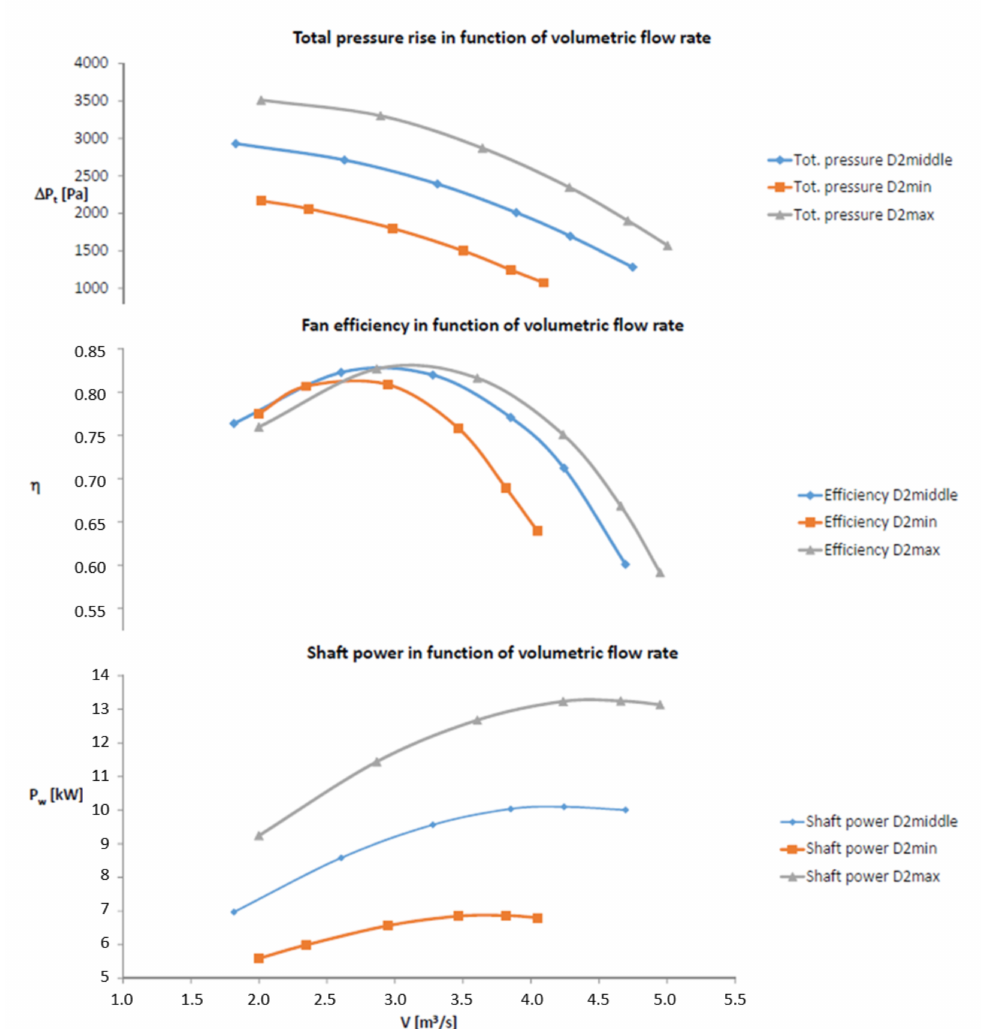
Figure 5. Fan curves of the three different positions of the movable